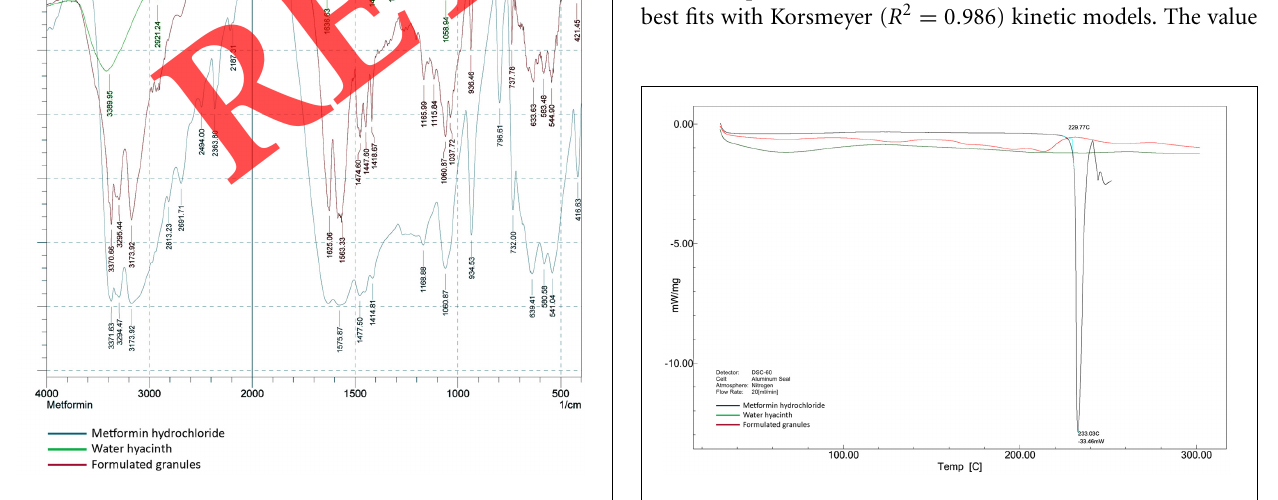
FIGURE 3 | DSC curve of Metformin HCl, Water hyacinth, and Formulated